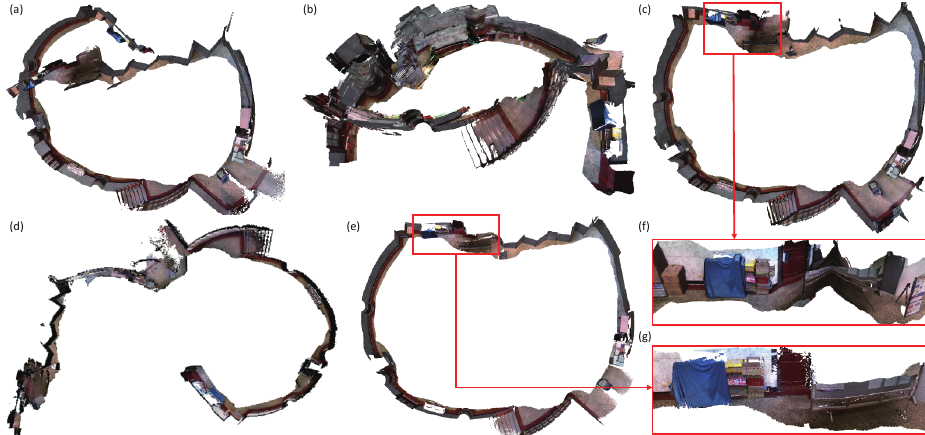
Figure 8. Comparison of departmental hall reconstruction results. ( a ) is reconstructed by ElasticFusion [11,12]. ( b ) is produced by BundleFusion [33]. ( c ) is generated by Kintinuous [36]. The system gave a poor result around the loop closure as displayed in ( f ). The surface was distorted. ( d ) is produced by InfiniTAM v3 [39]. ( e , g ) are reconstructed by our